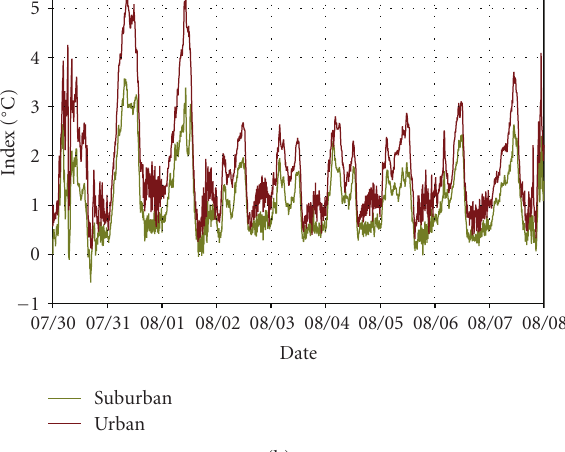
Figure 3: Composite urban (red), suburban (gold), and rural (blue) values of dew point temperature from 30 July 2008 to 8 August 2008.